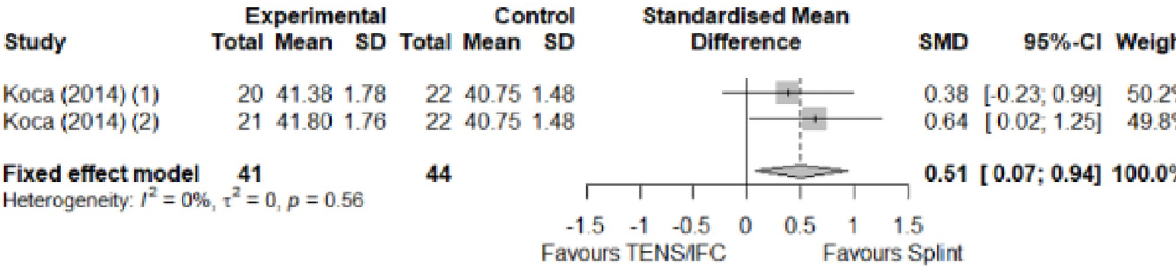
Fig 34. Electrophysical modalities versus splinting (sensory velocity). Studies with more than two intervention groups (different modalities) were numbered as (1) and (2).